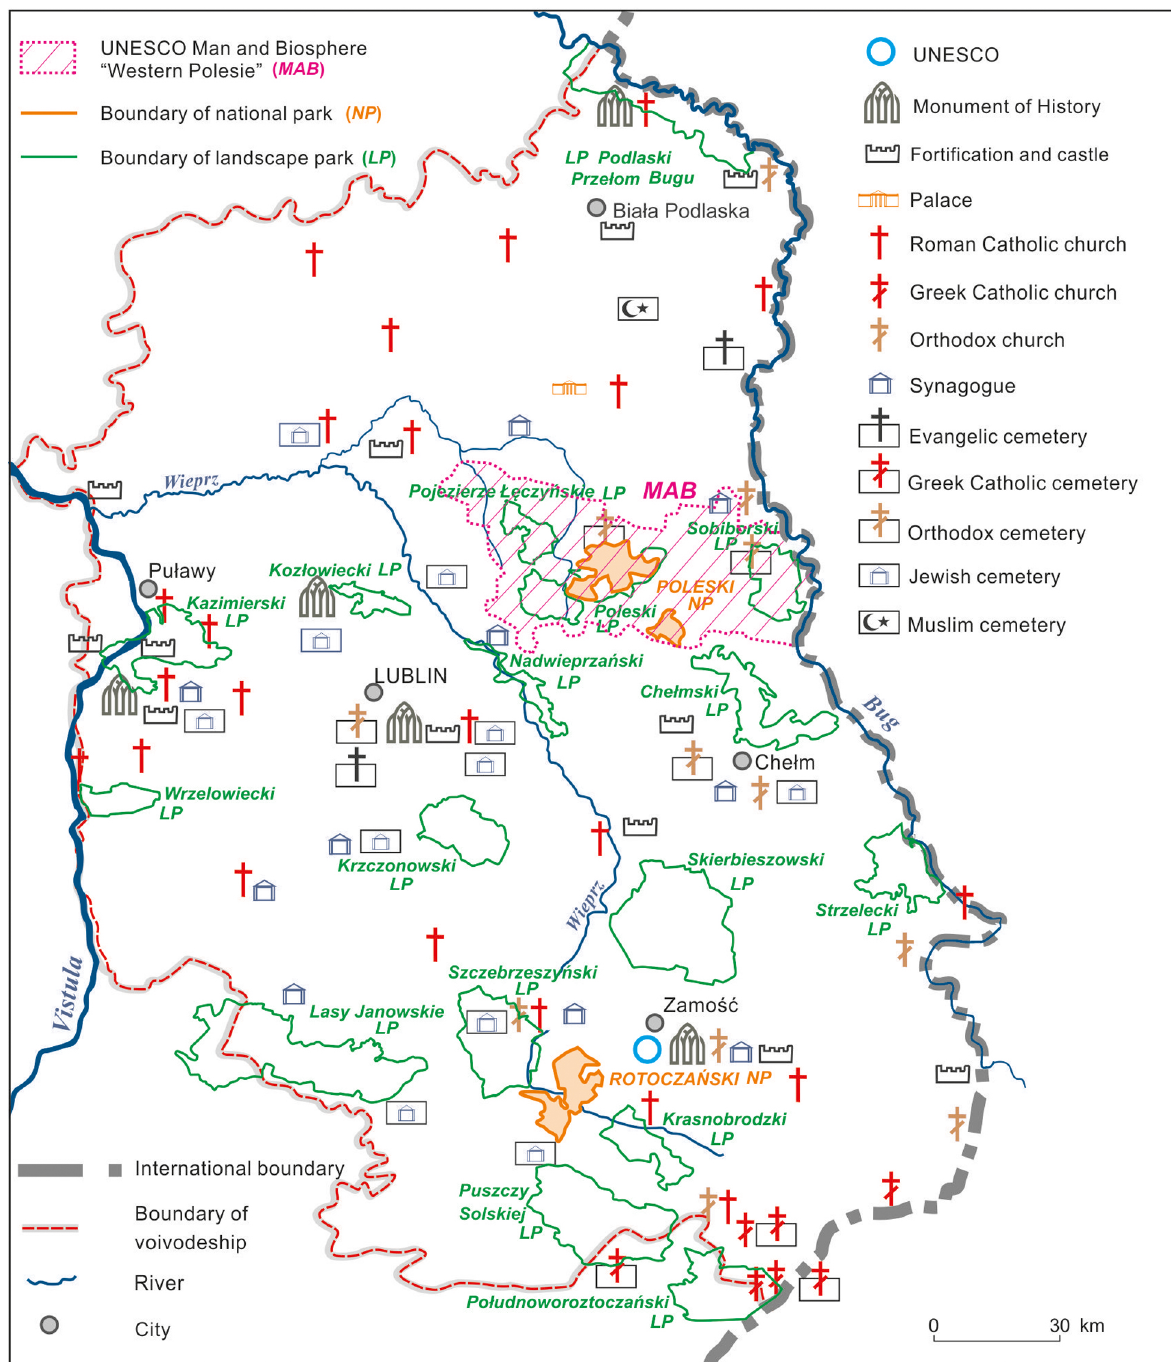
Fig. 1. The most valuable elements of the natural and cultural environment of the lubelskie